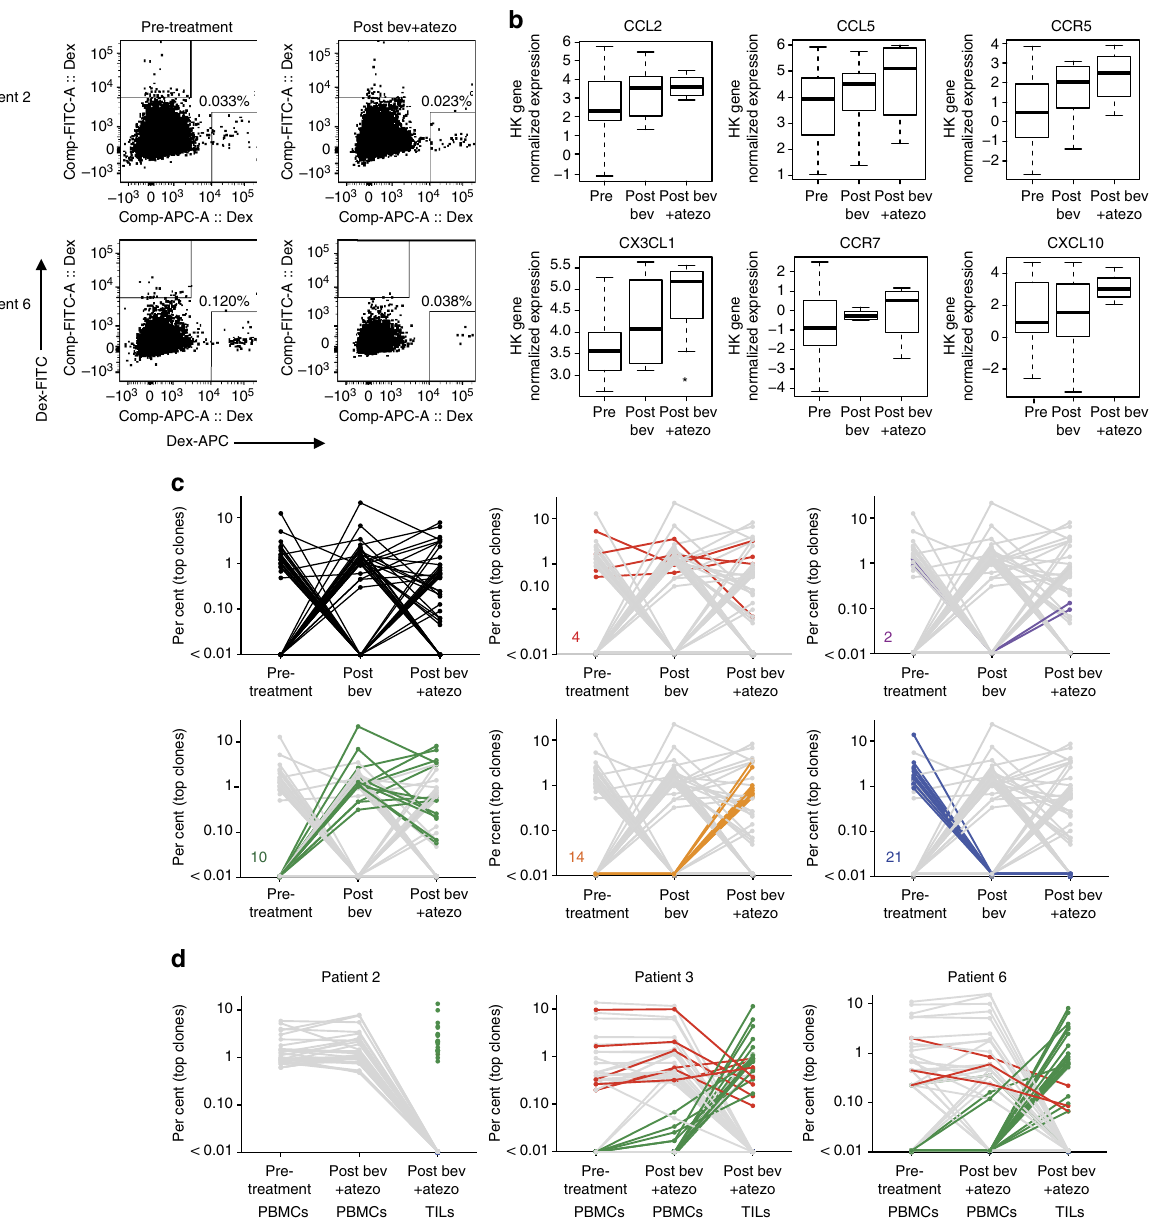
Figure 4 | Analyses of antigen-specific T cells in the blood and T-cell repertoire. ( a ) Flow cytometry analyses of antigen-specific T cells (dextramer positive). Representative data from two HLA-A2 positive patients with blood draws matched to tumour biopsy time points are shown. ( b ) Increased expression of chemokines, including CX3CL1 with treatment in tumours. The line in the middle of the box is plotted at the median. Lines above and below the boxes represent variability outside the upper and lower quartiles. ( c ) TCR b sequencing from patient 6 TILs before and after treatment. The top clones (up to 25) for each group are shown. Prevalence of trending TCR b clone populations are shown in red, blue, green, orange, and purple. ( d ) TCR b sequencing of patient 2, 3, and 6 pre-treatment PBMCs, post-bevacizumab (bev) and –atezolizumab (atezo) PBMCs, and post-bevacizumab and -atezolizumab TILs. The top clones (up to 25) for each group are